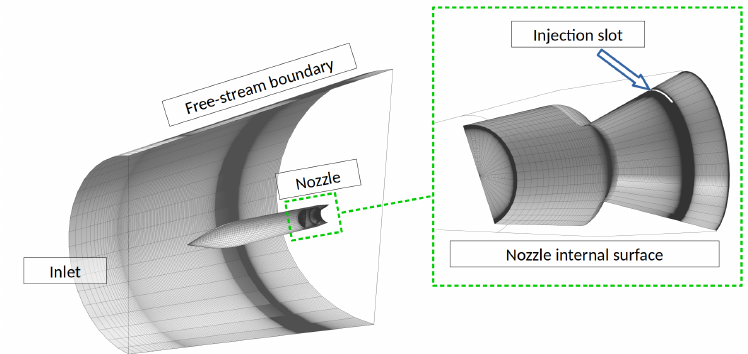
Figure 13. Three-dimensional (3D) mesh configuration: global view and nozzle detail.